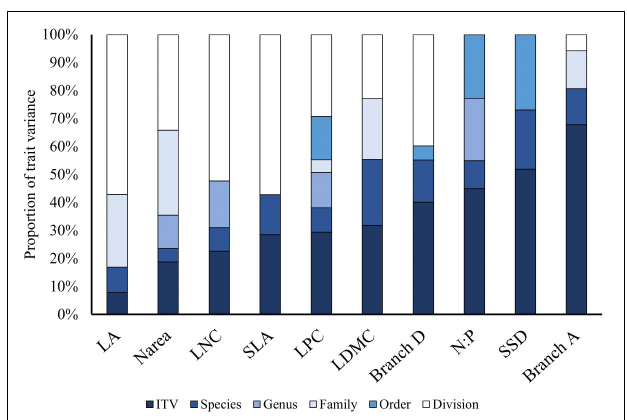
FIGURE 3 | Variance decomposition of measured leaf and stem economic traits across different taxonomic levels from communities spanning the temperate-boreal ecotone of the northeast United